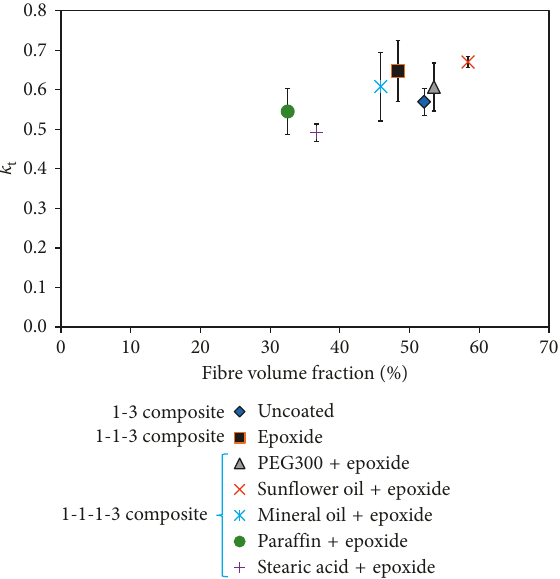
Figure 8: The electromechanical coupling factor ( k PZT-based composite discs with fibres dip coated in various soft polymers against the fibre volume fraction.